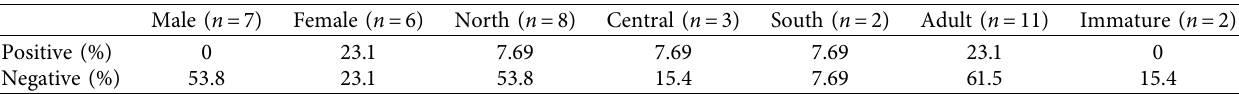
Table 2: Serological results for Toxoplasma gondii in 13 individual ocelots based on the percent of positivity regarding the gender, geographical location in Trinidad, adult, and immature